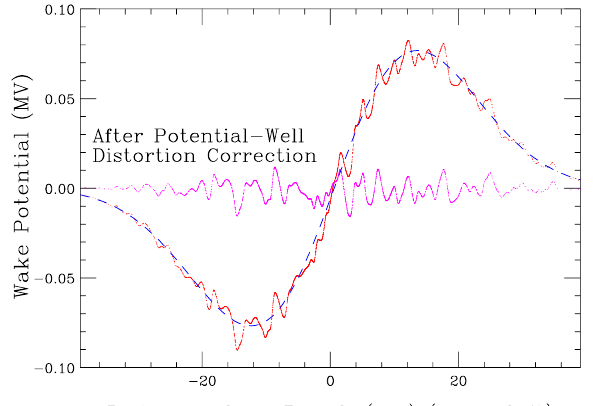
FIG. 6. (Color) Wake potential seen by the simulated bunch is shown by the red curve, which differs slightly from the wake potential of an ideal smooth Gaussian bunch shown in the blue dashed line. The difference shown by the magenta solid curve represents the random fluctuation of the finite number of